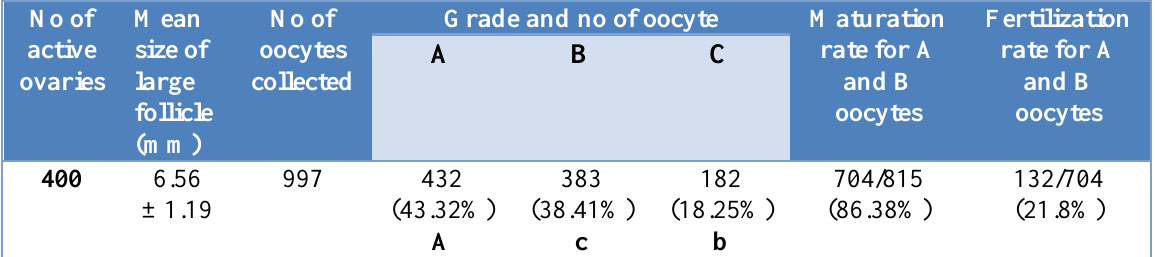
Table,1: The number of ovaries, large follicles, oocytes, grades of oocytes collected from slaughtered ewe, maturation and fertilization rate. No of active